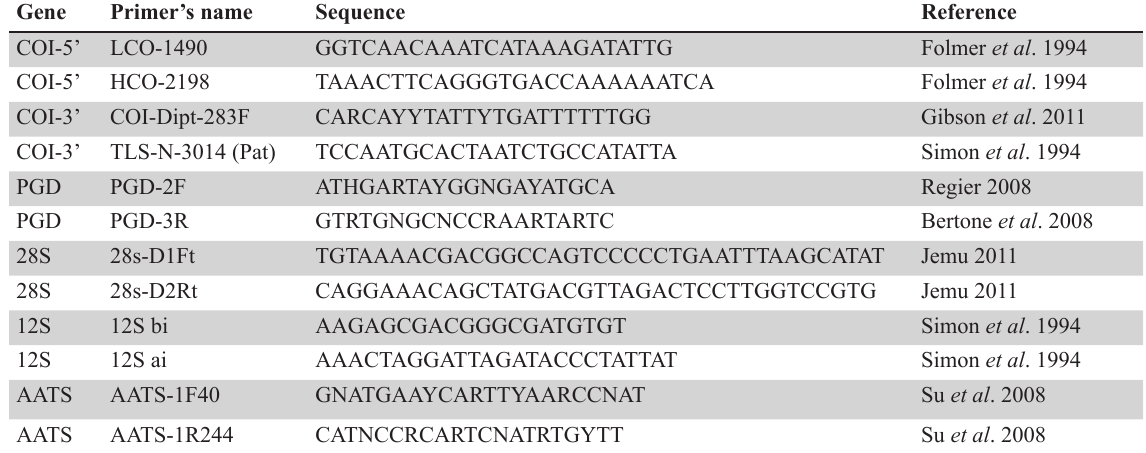
Table 2. Primers used for amplifying and sequencing the molecular